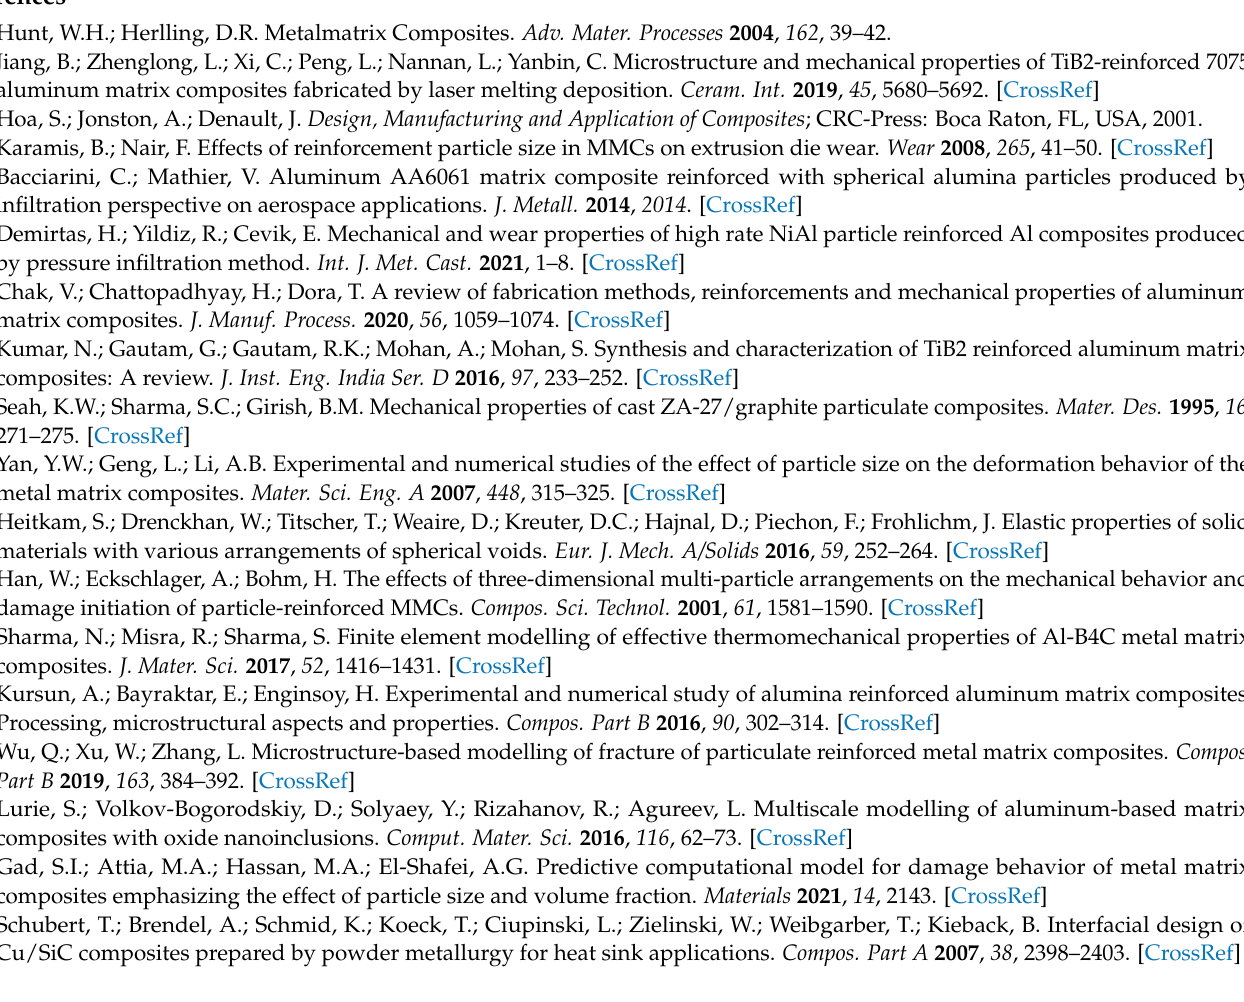
Figure A3. Particle area fraction as a function of unit cell size. Figure A3 demonstrates, for unit cell sizes smaller than 100 × 100 µ m 2 , the particle area fraction; as a result, effective elastic properties are unit-cell-size-dependent. Therefore, in the current study, all unit cells were equal to or larger than 100 × 100 µ m 2 .